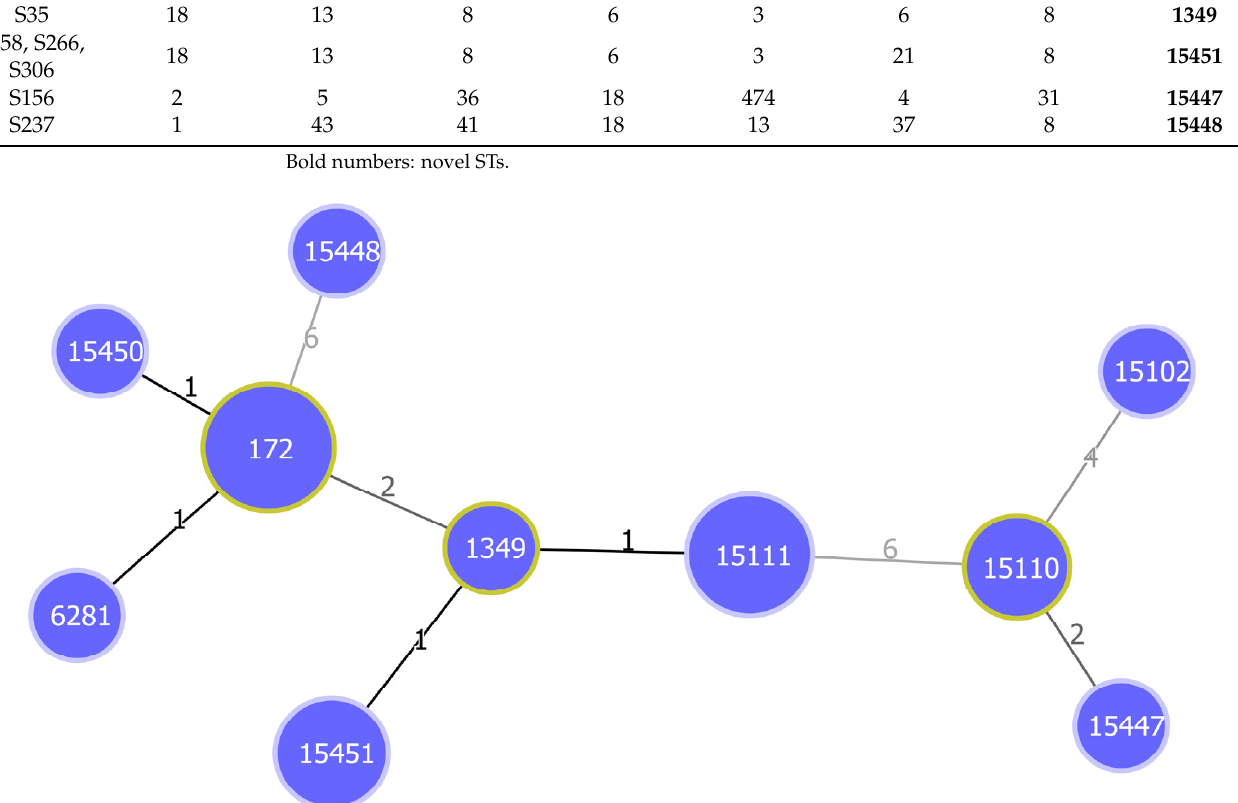
Figure 2. Minimum spanning tree (MST) showing the genetic relationship between STs obtained from MLST of serotype 23B strains. The tree was generated using the goeBurst algorithm in PHYLOViZ software. The diameters of nodes are proportional to the number of isolates. Founder STs have yellow color around their nodes. Branch labels correspond to the number of allelic variations between STs; branch lengths are not to scale.